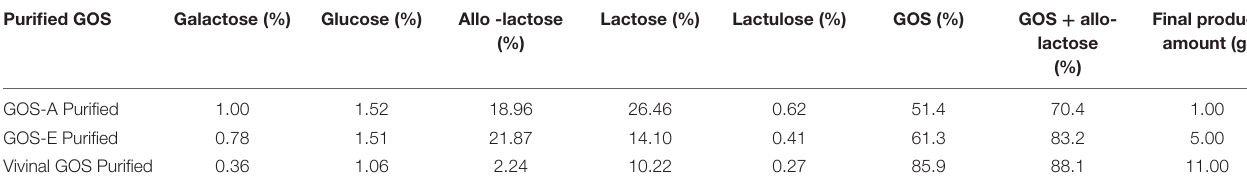
TABLE 3 | Di- and tri- saccharides present in GOS-A and GOS-E and corresponding relative%. Compound Peak Number * Monosaccharides